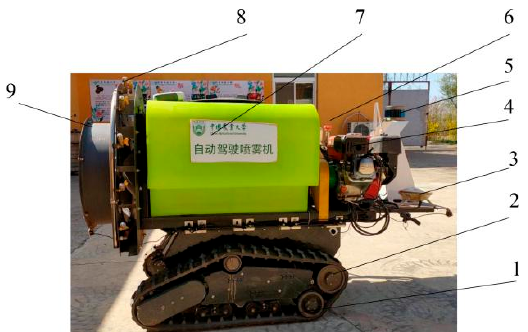
Figure 1. PVSR. 1. rubber track, 2. active wheel, 3. RTK GNSS, 4. gasoline engine, 5. 3D LIDAR, 6. piston pump, 7. tank, 8. variable nozzle, 9. axial